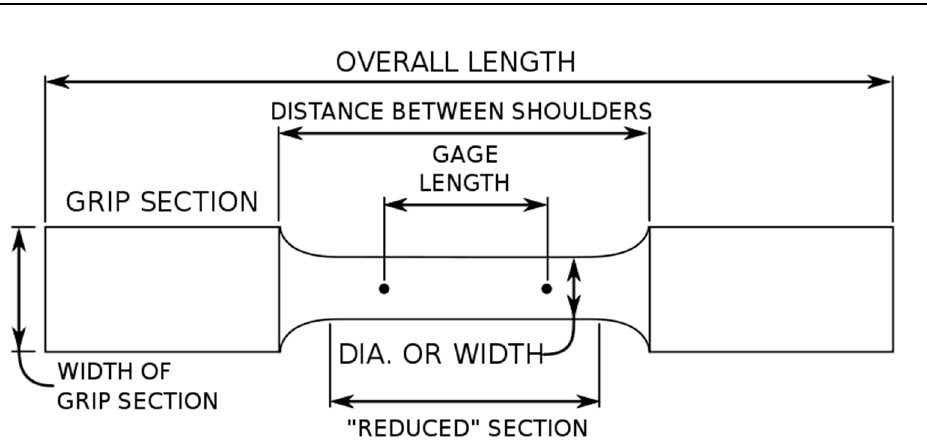
Figure 3. Orientation of the tensile test specimens.